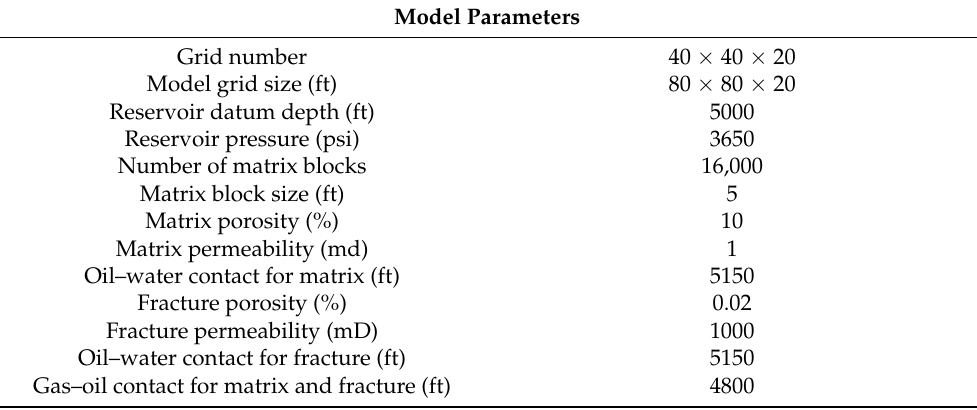
Table 2. Reservoir properties.